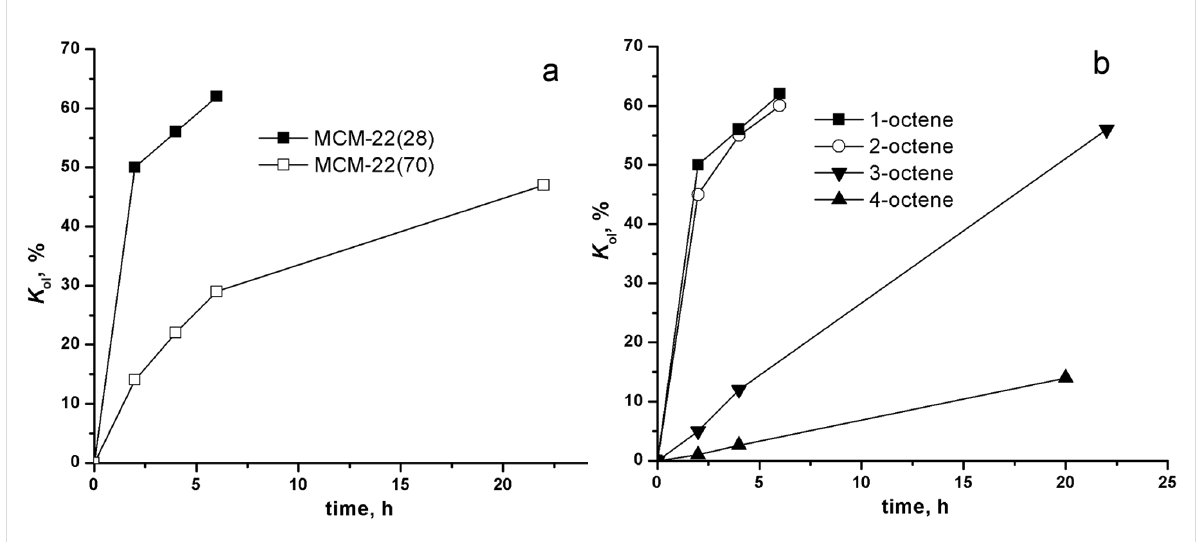
Figure 5: Conversion to oligomers for 1-octene over MCM-22(28) and MCM-22(70) (a) and conversion to oligomers for 1-octene, 2-octene, 3-octene, and 4-octene over MCM-22(28) (b). 50 mg Support, 1.5 mL octene, 40 °C.